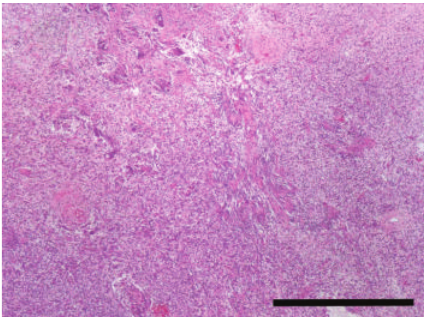
Figure 4: Perivascular wall tumor; right piriform lobe. The majority of the mass is comprised of spindle cells arranged in haphazardly oriented bundles. H&E × 40. Bar = 1mm.